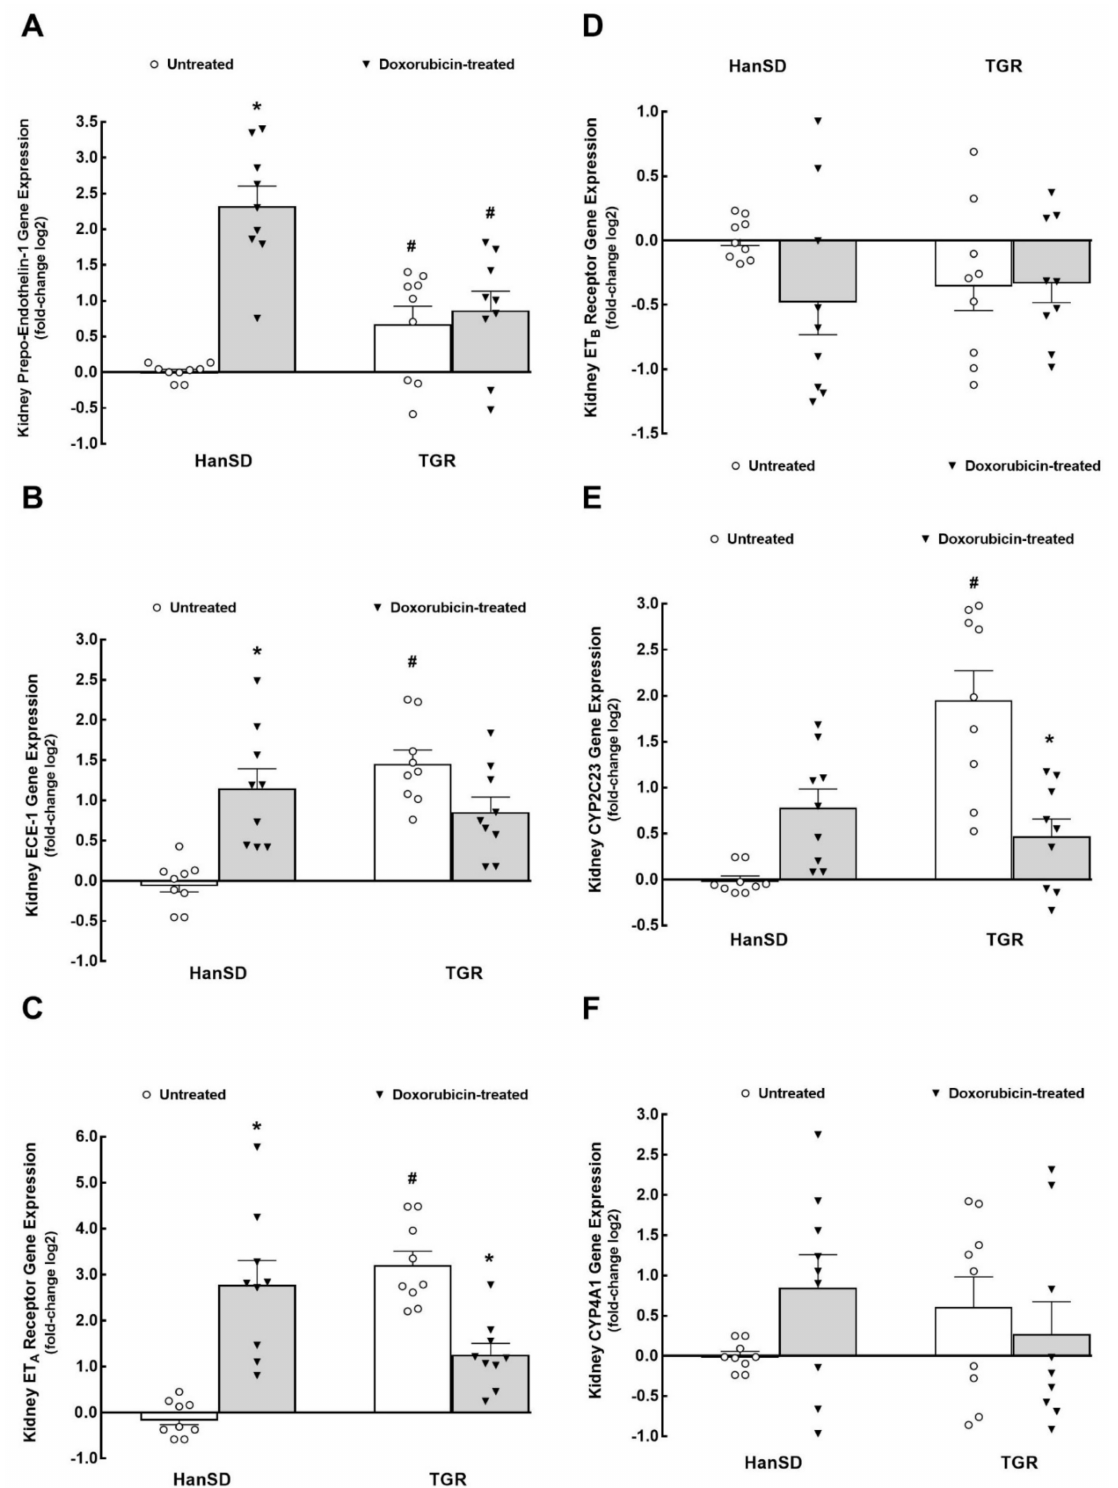
Figure 5. The second part of kidney mRNA expression. Kidney prepro-Endothelin-1 ( A ), endothelin-converting enzyme type 1 ( ECE-1 ) ( B ), endothelin type A ( ET A ) receptor ( C ), endothelin type B ( ET B ) receptor ( D ), cytochrome P-450 subfamily 2C23 ( CYP2C23 ) ( E ) and cytochrome P-450 subfamily 4A1 ( CYP4A1 ) ( F ) gene expression in untreated and doxorubicin- treated normotensive, transgene-negative Hannover Sprague–Dawley (HanSD) and hypertensive, Ren-2 transgenic (TGR) rats. * p < 0.05 compared with untreated animals of the same strain. # p < 0.05 versus HanSD rats within the same protocol. The values are means ± SEM. Statistical comparison was made by one-way ANOVA